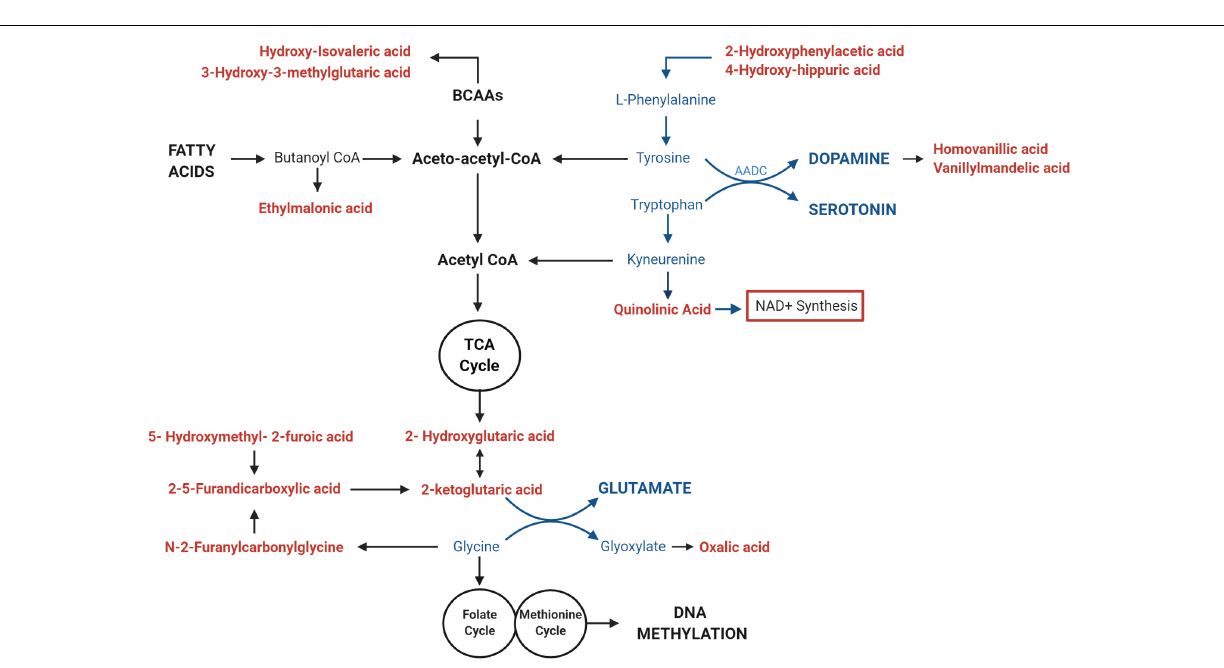
FIGURE 6 | Mitochondrial DNA (mtDNA) copy number correlates with urinary metabolites implicating mitochondrial metabolism and neurotransmitter synthesis. Urinary metabolites that most significantly correlate with mtDNA copy number ( p < 0.01) converge on pathways involved in the metabolism of fatty acids (ethylmalonic acid); Branched Chain Amino Acids (BCAAS) (hydroxy-isovaleric acid, 3-hydroxy-3-methylglutaric acid); and neurotransmitters including Dopamine (2-hydroxyphenylacetic acid, 4-hydroxyhippuric acid, vanillylmandelic acid, and homovanillic acid), Serotonin (Quinolinic acid), Glutamate (2-ketoglutaric